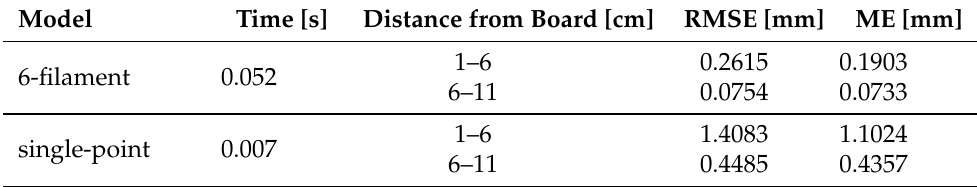
Table 3. Speed and accuracy of the 6-filament and the single-point models used in a simulated electromagnetic tracking experiment. Scatter plot of the error is shown in Figure 13. Computation time is calculated as the average solution time for 512 random test